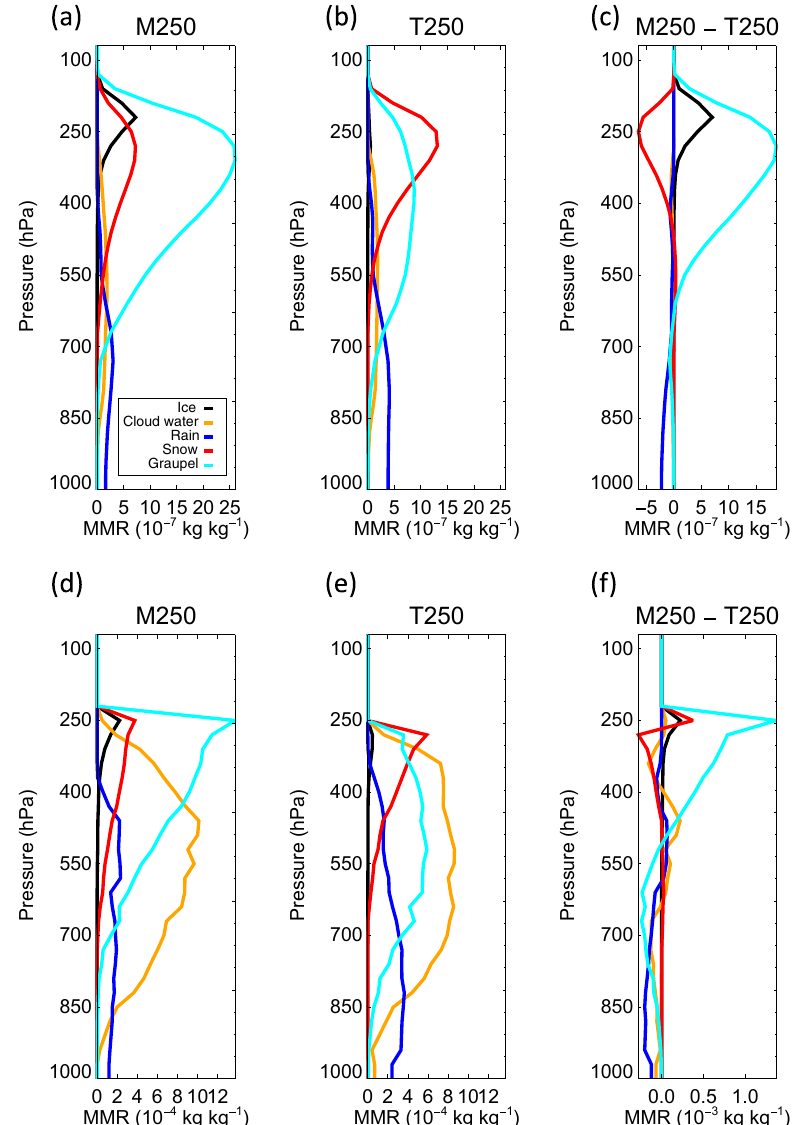
Figure 8. Idealised supercell: mean vertical profiles of hydrometeor mass mixing ratios (MMRs), as in Fig. 6, averaged over the 2h of the supercell simulation. (a) SUPER-M250 domain mean, (b) SUPER-T250 cloudy column domain mean, (c) SUPER-M250 domain mean minus SUPER-T250 domain mean, (d) SUPER-M250 condensate mean of each hydrometeor class, (e) SUPER-T250 condensate mean and (f) SUPER-M250 condensate mean minus SUPER-T250 condensate